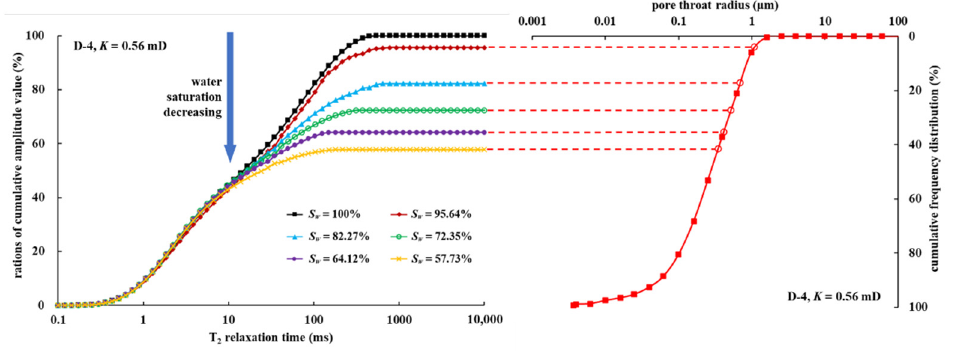
Figure 4. T 2 accumulative curve under different water saturation and accumulative distribution curve of core plug D-4.